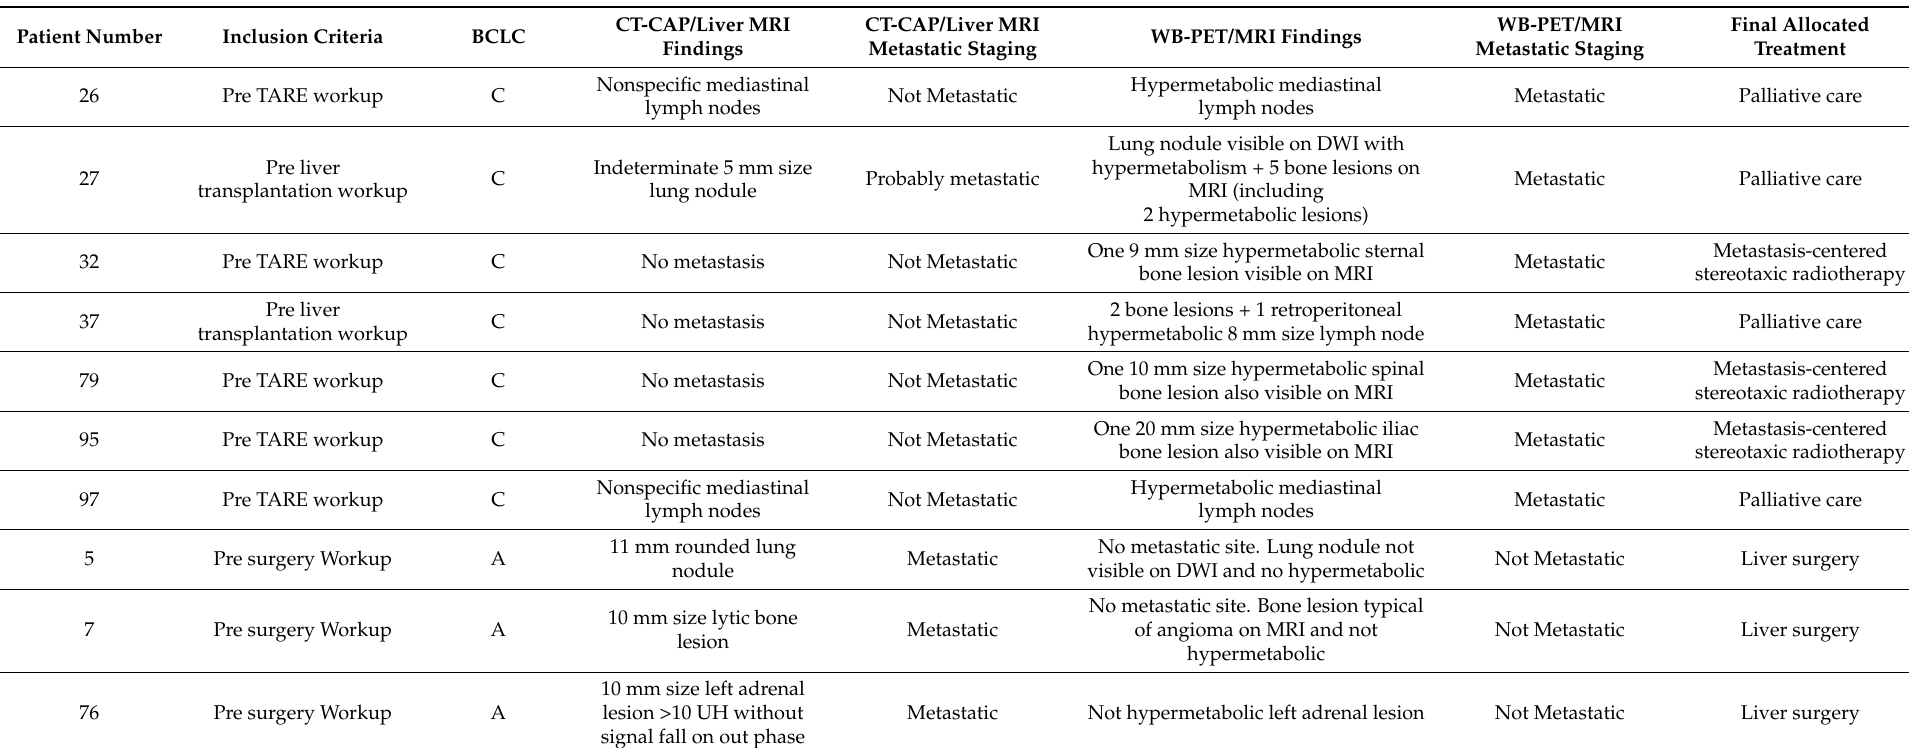
Table 3. Impact of the WB-PET MRI on patient management compared to the standard of care CT-CAP/liver MRI